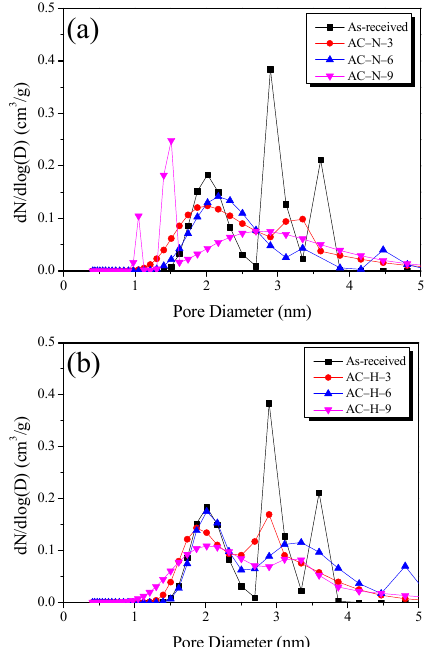
Figure 7. Pore size distribution of AC heat ‐ treated under different atmospheres based on the NLDFT method: ( a ) N 2 ; ( b ) H 2 /N 2 mixed gas.